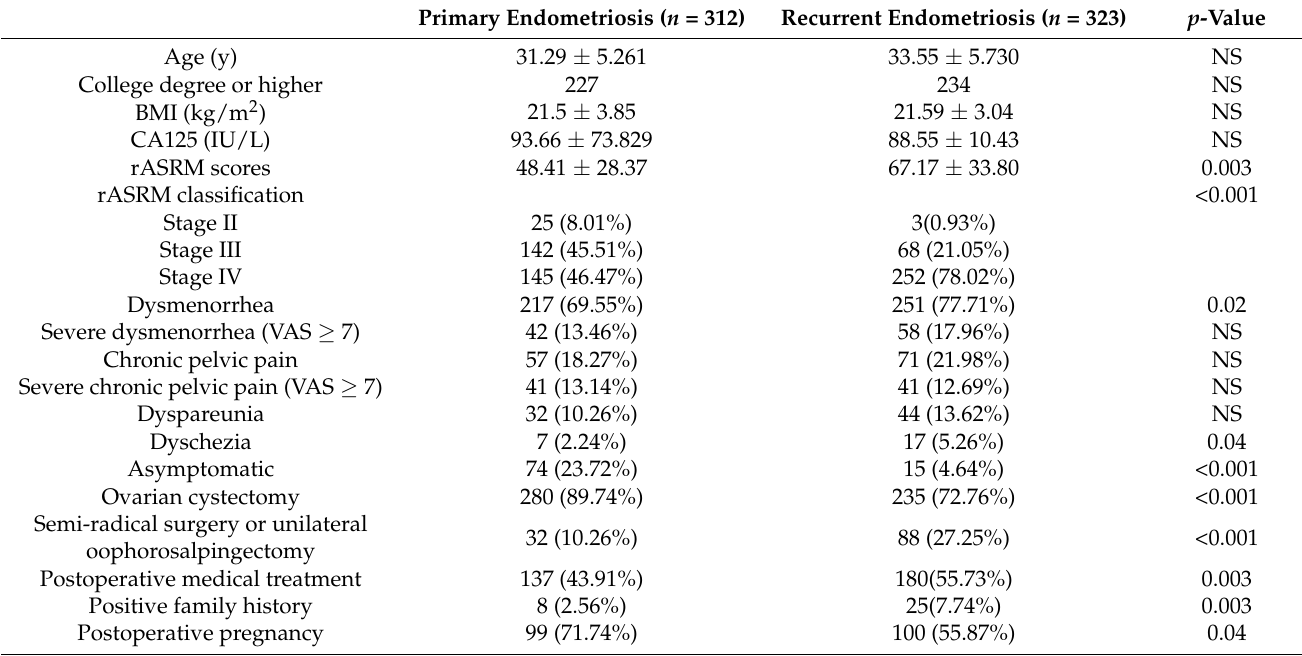
Table 1. Characteristics of primary and recurrent endometriosis